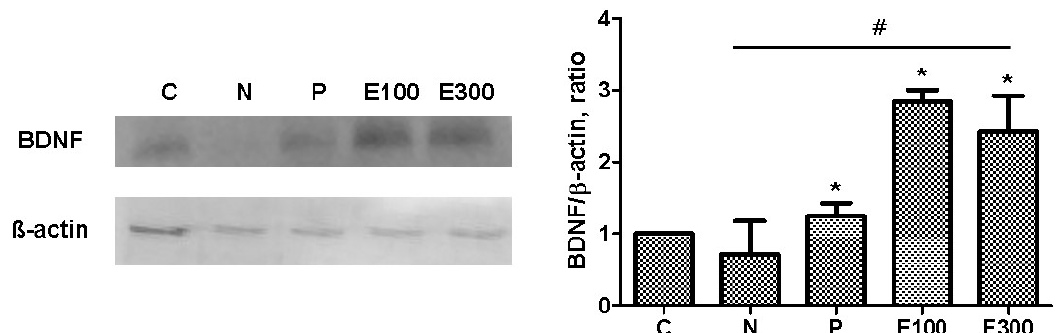
Figure 5. Western blot of brain-derived neurotrophic factor (BDNF) in the hippocampus. C: normal control; N: negative control (CUMS); P: positive control (CUMS + 15 mg / kg fluoxetine); E100 and E300: doses of the extract (CUMS + 100 and 300 mg / kg, respectively). The intensities of the bands were quantified with a densitometer ( n = 3). The β -actin was used to normalize the BDNF. #: Kruskal-Wallis test; *: Mann-Whitney test. #: p < 0.05; *: p < 0.05.